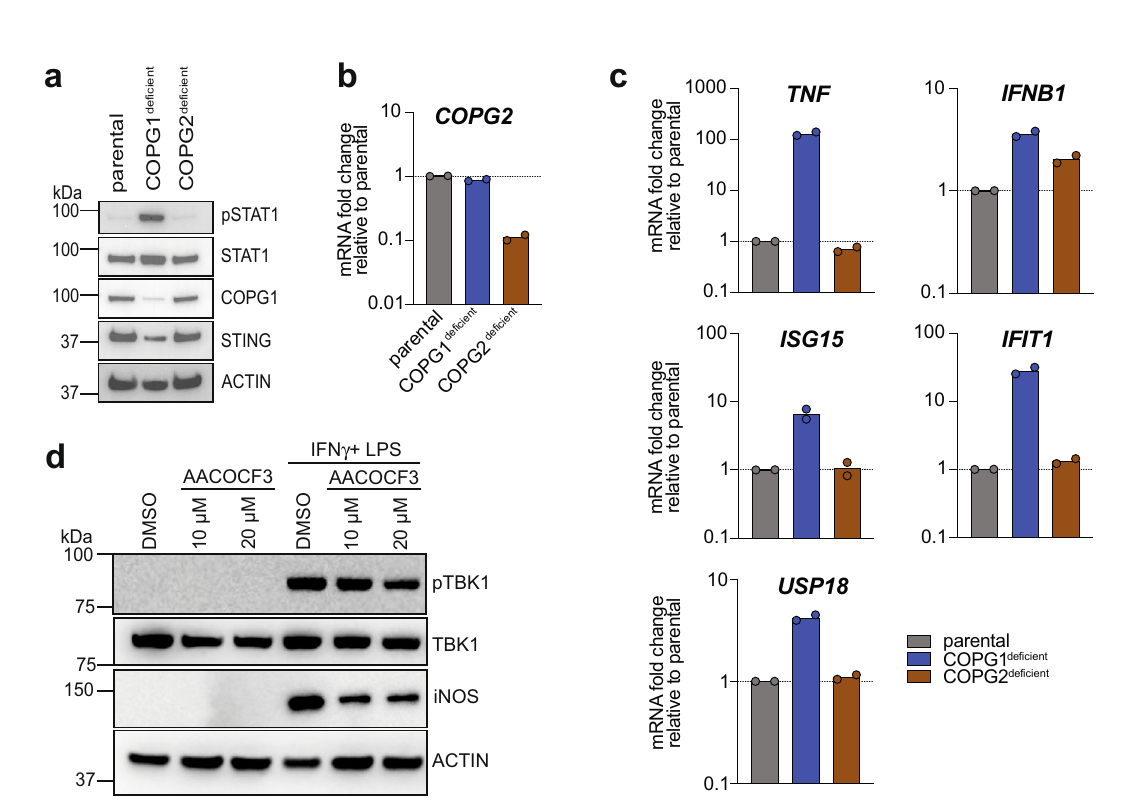
Fig. 5 cGAS/STING pathway activation is caused by general de fi ciency in COPI-mediated retrograde traf fi cking. a Schematic illustration of coatomer complexes COPII (green) and COPI (blue) mediating intracellular traf fi cking between endoplasmic reticulum (ER) and Golgi compartments. The COPII complex mediates anterograde transport from ER to Golgi, whereas COPI mediates retrograde transport from Golgi to ER as well as within cis-Golgi compartments. COPI vesicle formation occurs at the Golgi membrane through interaction of 7 subunits: α (COPA), β (COPB1), β ’ (COPB2), δ (COPD), ε (COPE), γ (COPG), ζ (COPZ). After vesicle budding, the coatomer coats are shed off and released into the cytoplasm to allow vesicle fusion at the target membrane 2 . b Representative IF images of parental, COPA de fi cient , COPG1 de fi cient and COPD de fi cient HeLa cells co-stained for KDEL (green), GM130 (magenta), indicated COPI subunit (cyan) and DAPI (blue). Images are presented as maximum intensity projection. Scale bar 10 µ m. c Quanti fi cation of IF co-localization of KDEL and GM130 signal in COPI subunit-de fi cient HeLa cells shown in ( b ). Results are quanti fi ed as percentage area of KDEL localization (ER-speci fi c retention signal) inside cis-Golgi (GM130). Each dot represents one single cell. Parental cells stained for different subunits were combined for quanti fi cation analysis. Statistical signi fi cance was assessed by one - way ANOVA with Dunnett ’ s multiple comparison test using n = 35 (parental), n = 8 (COPA de fi cient ), n = 15 (COPG1 de fi cient ) and n = 18 (COPD de fi cient ) biologically independent cells examined in 2 independent experiments. Line at median. d Immunoblot analysis of THP-1 cells after CRISPR/Cas9-mediated genetic deletion of COPI-subunit proteins COPA, COPG1, COPD and COPE following treatment with STING inhibitor H-151 (2.5 µ M). Results are shown as a representative of n = 3 independent repeats e qRT-PCR analysis of proin fl ammatory genes and ISGs in COPI-subunit de fi cient THP-1 cells following H-151 treatment (2.5 µ M). Data are shown as mean ± SEM from n = 3 independent experiments and statistical signi fi cance was assessed by two-tailed ratio paired Student ’ s t -test comparing Veh ctrl and H-151 treatment individually for each cell line. P values are indicated by numbers or as * P < 0.05 , ** P < 0.01 , *** P < 0.001, * *** P < 0.0001 . Source data are provided as a Source Data fi le for Fig. 5c, d.